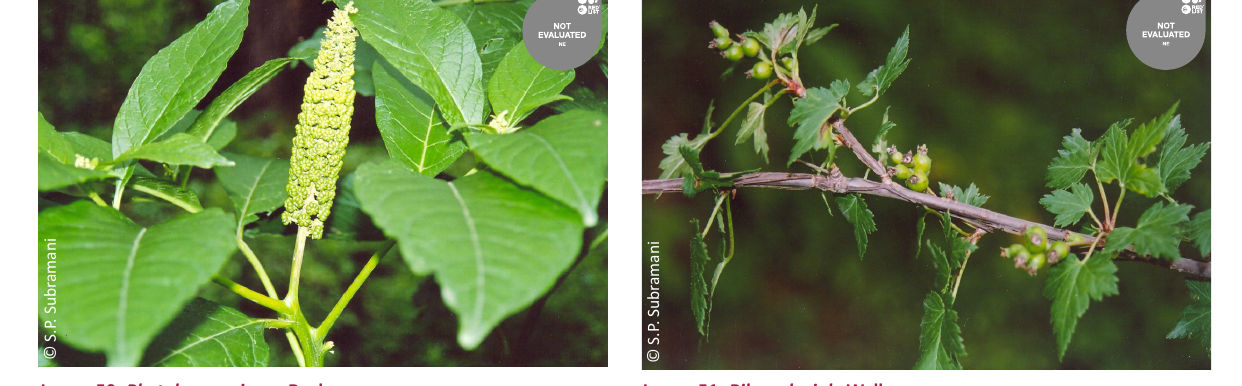
Image 50. Phytolacca acinosa Roxb. Image 51. Ribes glaciale Wall.